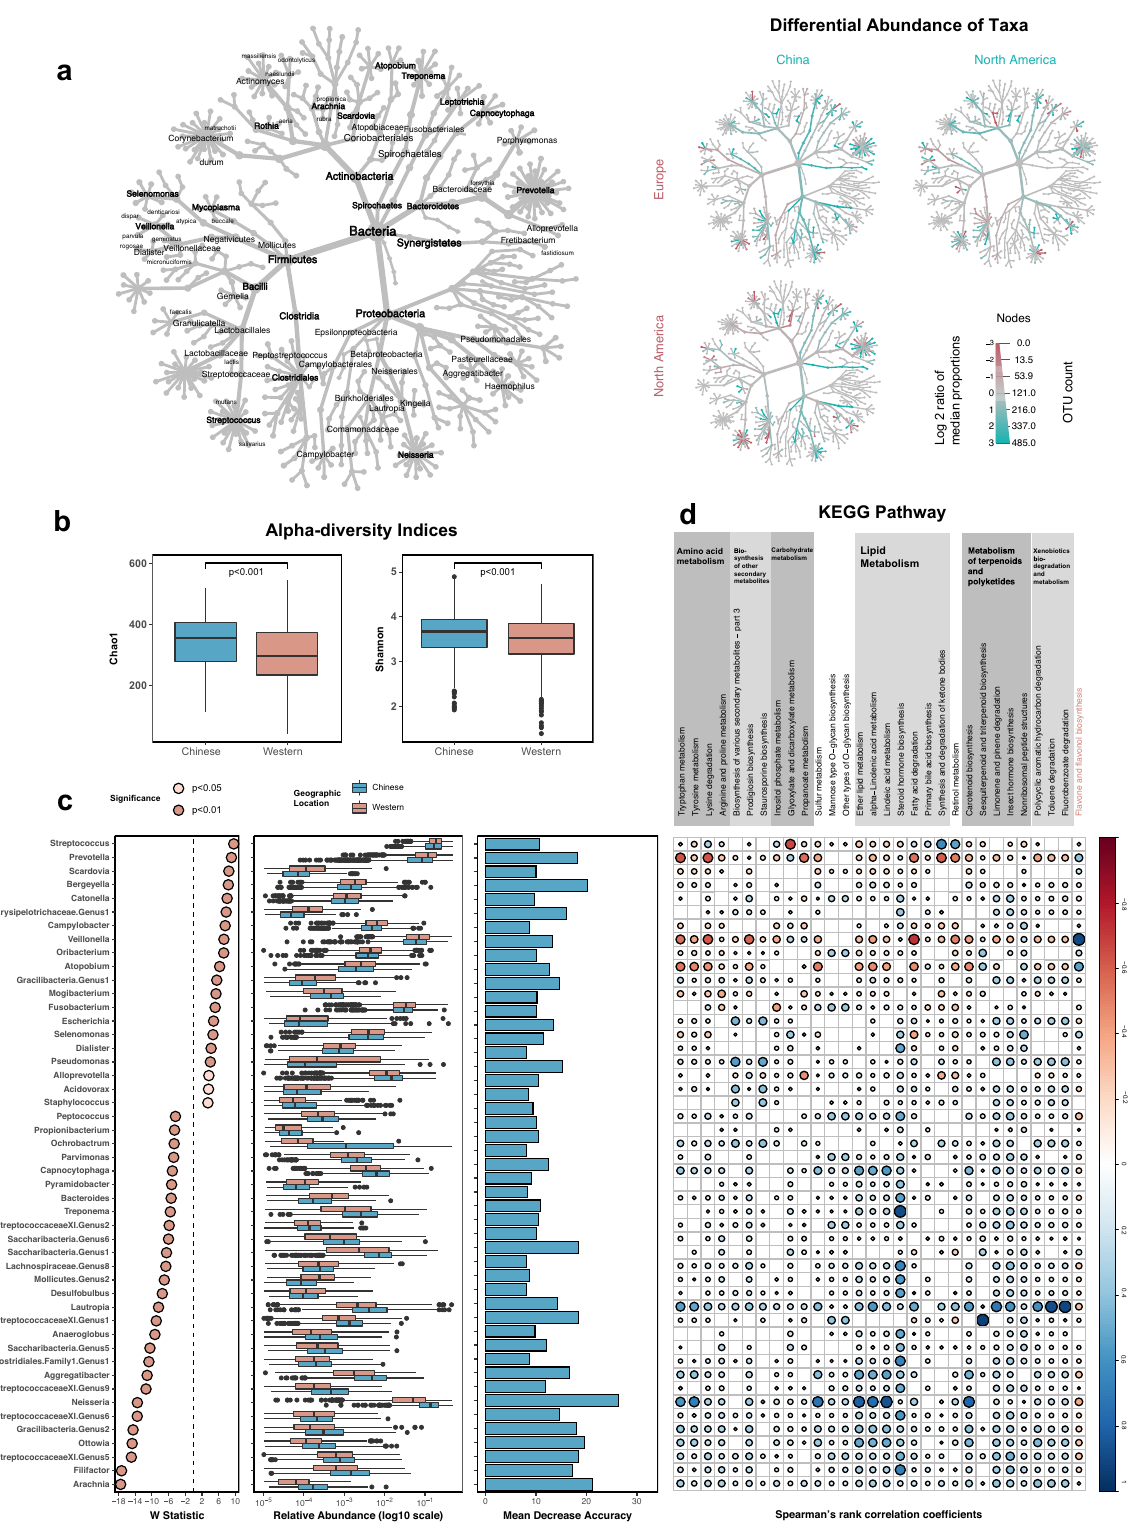
we examined the differences between Chinese and Western in the salivary microbiota at the genus and species level (Supplementary Tables 6, 7). Besides establishing a random forest model, we also identi fi ed differential taxa using ANCOM-BC, adjusting for